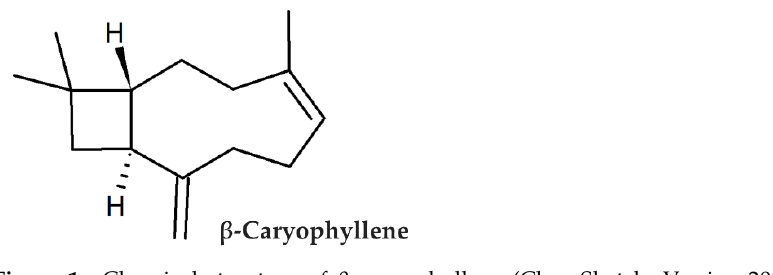
Figure 1. Chemical structure of β -caryophyllene (ChemSketch, Version 2018.1.1 free software, ACD/Labs, Toronto, ON, Canada).